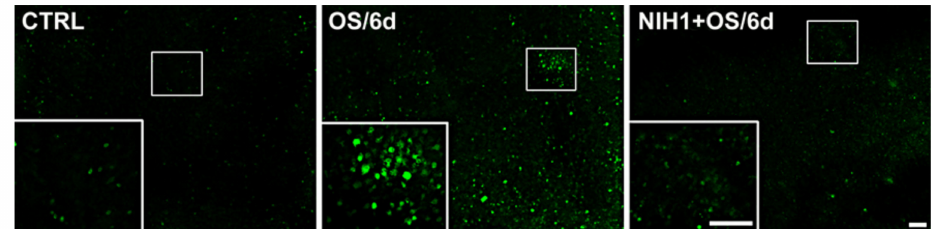
Figure 7. Effect of NIH1 on ROS levels. Visualization of ROS in CTRL, OS/6d, and NIH1 + OS/6d explants using the DCFH-DA assay. Insets are higher-power images of the boxed areas. Scale bar, 100 µ m (50 µ m for the insets).